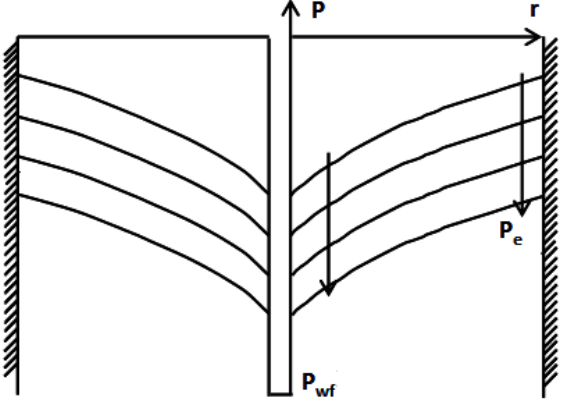
Figure 1—Pressure distribution under pseudo steady state .